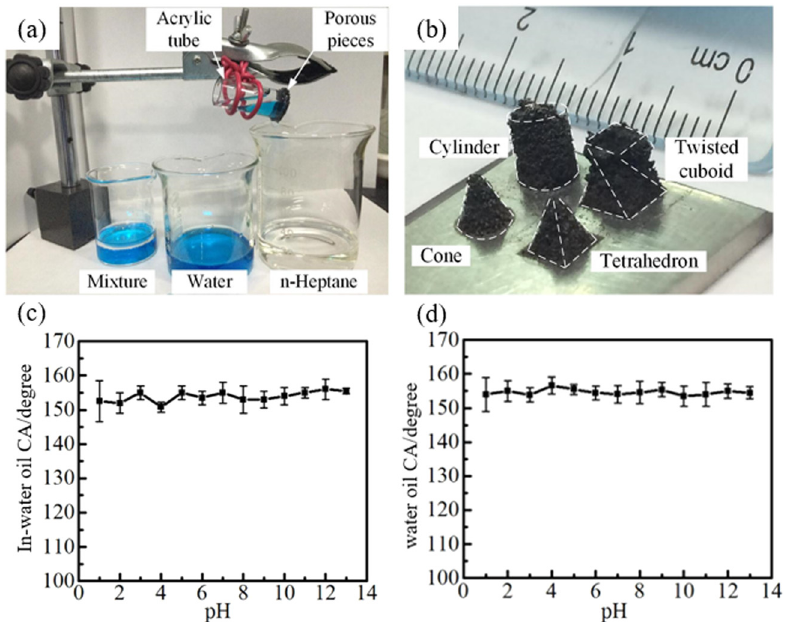
Figure 7: ( a ) Flowing/dynamic oil/water separation tests showing a complete oil/water separation with no water passing through the HMS sample ( water is dyed blue for illustration purpose ) . ( b ) Various structures of HMS samples that have been manufactured by ISLM techniques. ( c ) In - water CA of the HMSs after being immersed in aqueous solutions of various pH 1 – 13 for 12 h; ( d ) water CA of the surface modi fi ed samples after being immersed in aqueous solutions of various pH 1 – 13 for 12